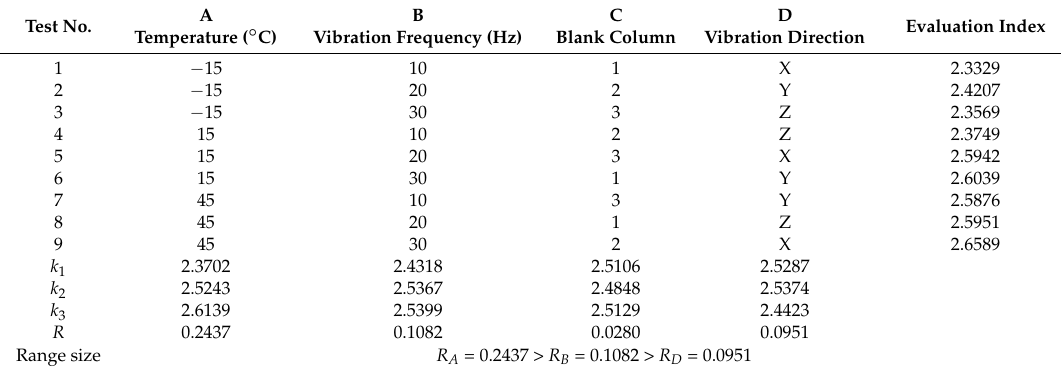
Figure 13. The trend chart between the levels of factors and the mean values. Table 14. The range analysis of the discharge capacity of the Cell 17.